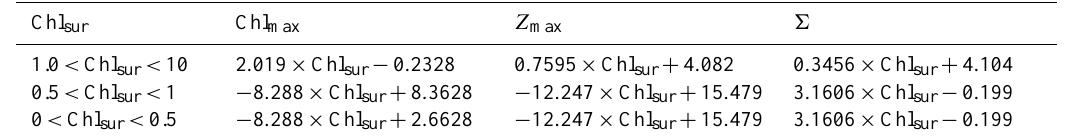
Table 4. Empirical relationships of the chlorophyll profile parameters ([Chl] max , Z max and σ) for the various ranges of surface chlorophyll [Chl] sur from different stations.